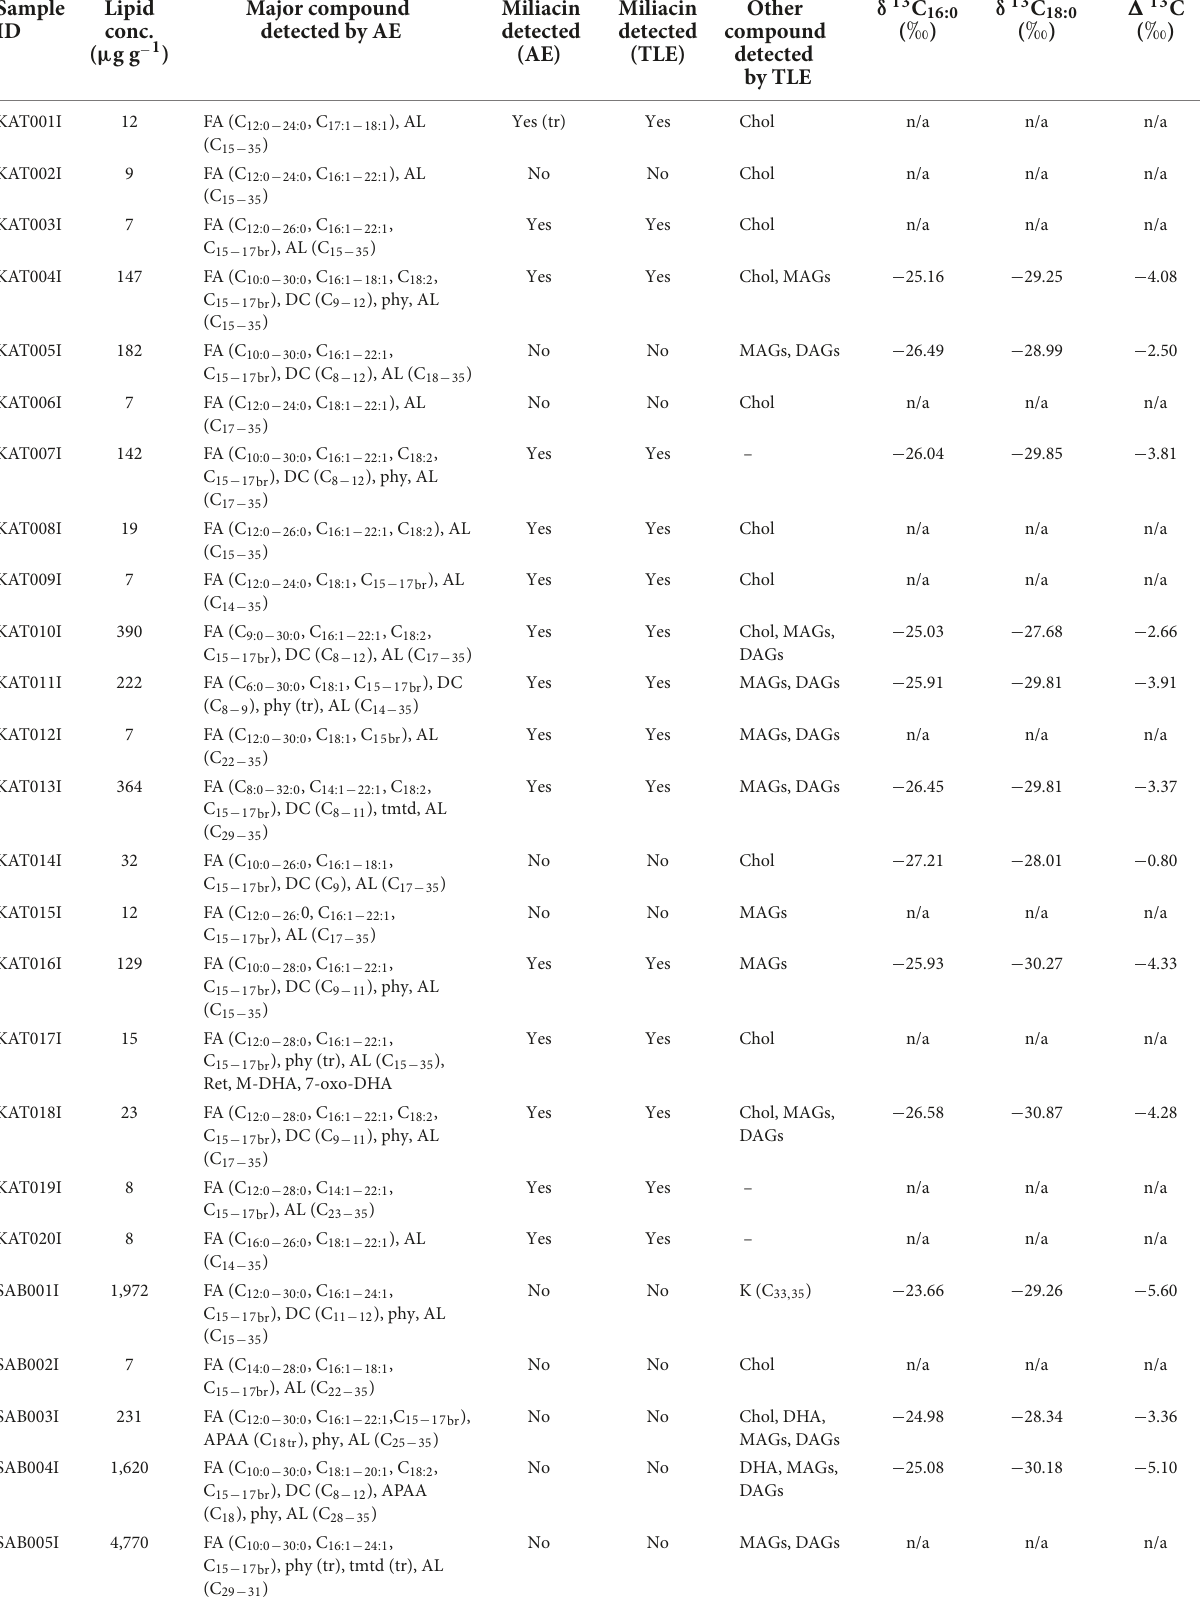
TABLE 1 The summarized results of lipid residue analysis of